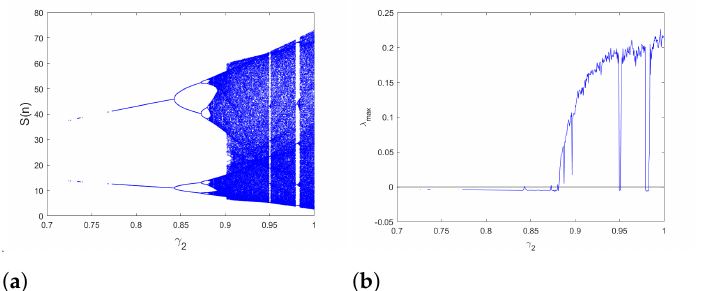
Figure 11. ( a ) Bifurcation diagram versus γ 2 of the fractional discrete SIR model (11) for α = 4 and γ 1 = 0.94. ( b ) The maximum Lyapunov